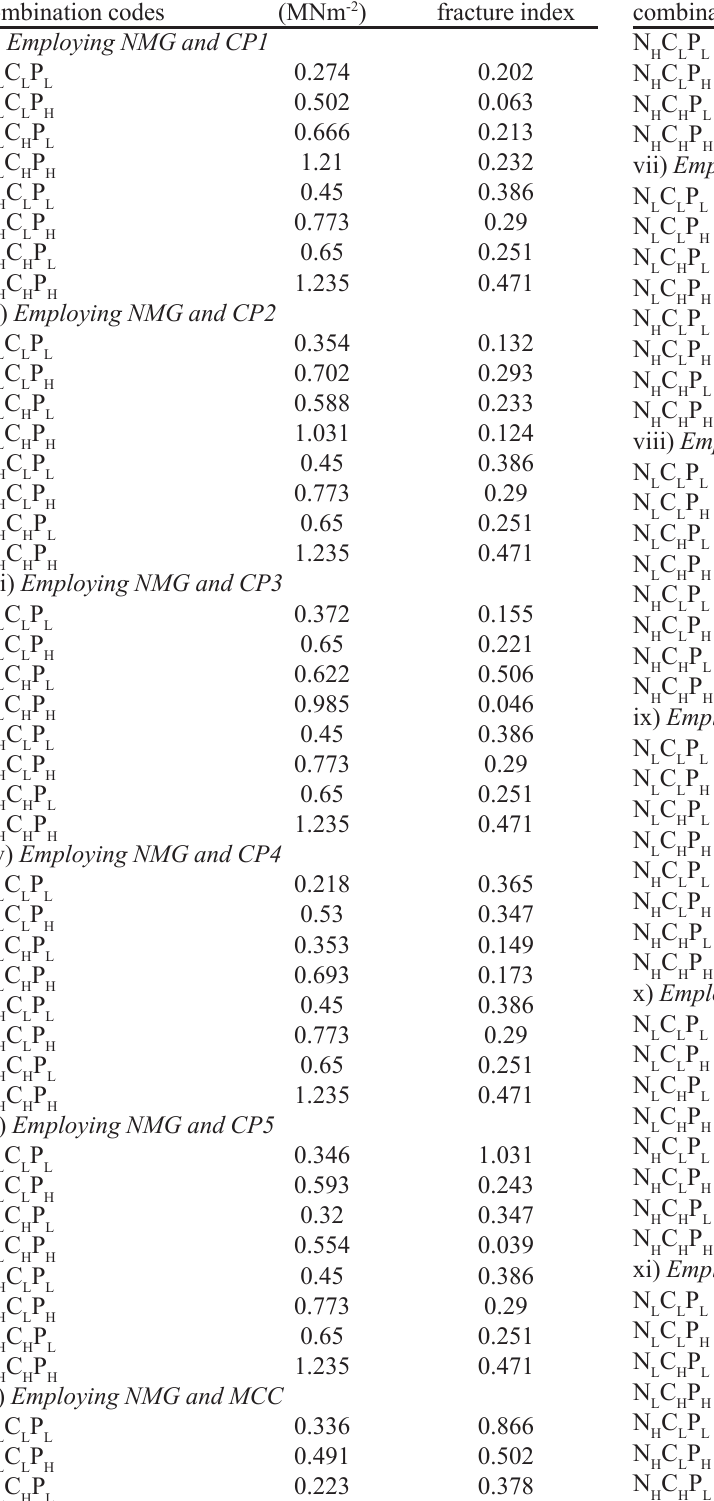
TABLE II - Values of tensile strength and brittle fracture index of paracetamol tablets for factorial experimental design Variables